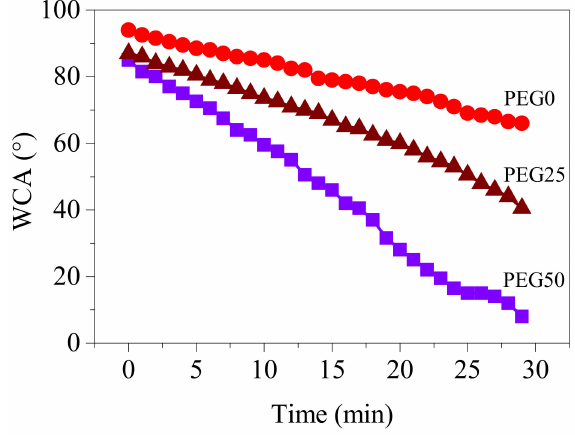
Figure 11. Variation of water contact angle with time for coatings.